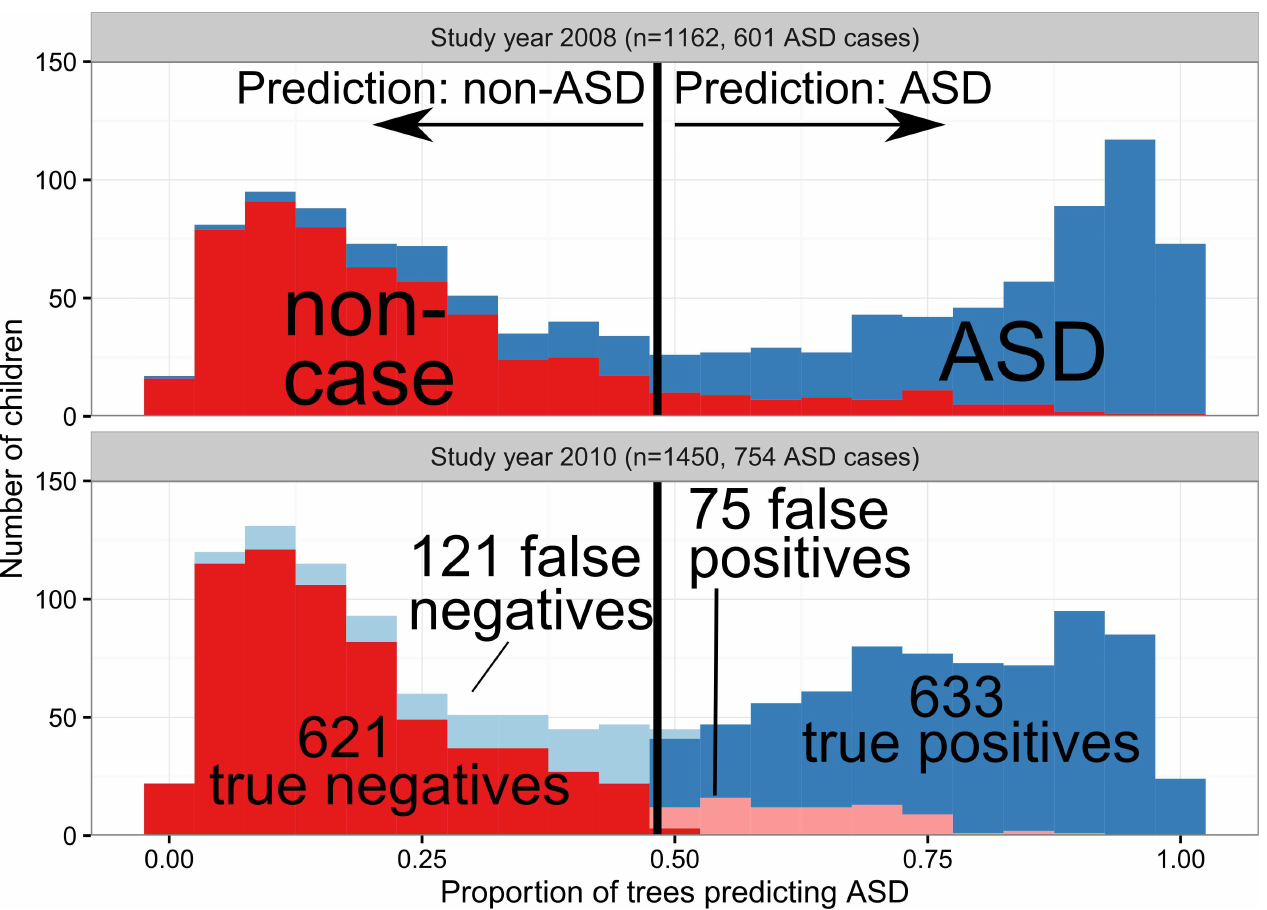
Fig 1. Histograms of prediction scores (x-axis) compared to clinician-assigned surveillance case definition (blue: autism spectrum disorder (ASD), red: non-ASD). Horizontalbar representsclassificationscore threshold. Upper panel: classifications for 2008 (training)data. Bottom panel: 2010 (test) data, discordant classificationsare highlighted in a lighter shade of blue or red.